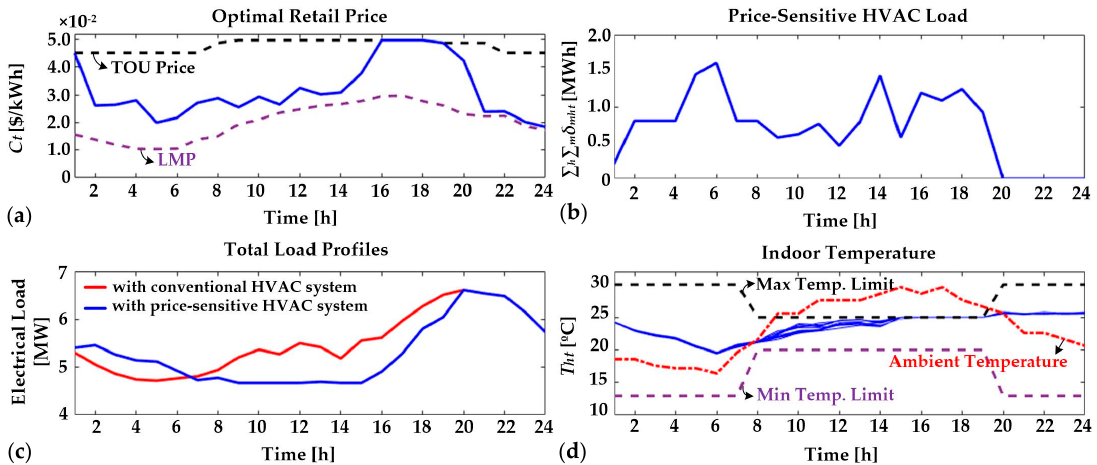
Figure 9. Optimal profiles for the proposed pricing strategy considering load leveling with the duck curve: ( a ) The optimal retail price, ( b ) total input power of the price-elastic HVAC units, ( c ) total load profiles, and ( d ) indoor temperature variations in 15 building rooms.